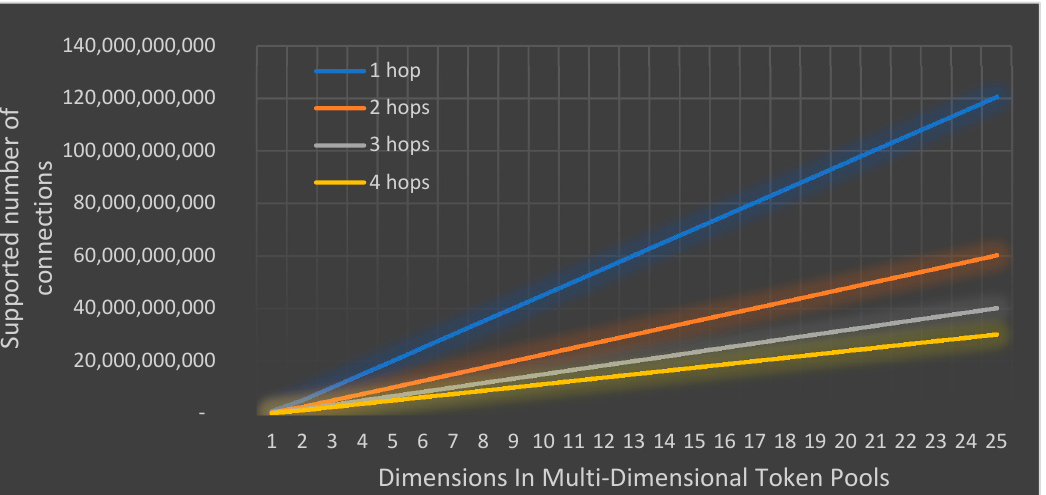
Figure 17 . The effect of token pools’ dimensionality on the supported number of achievable simultaneous connections and/or state-channels.